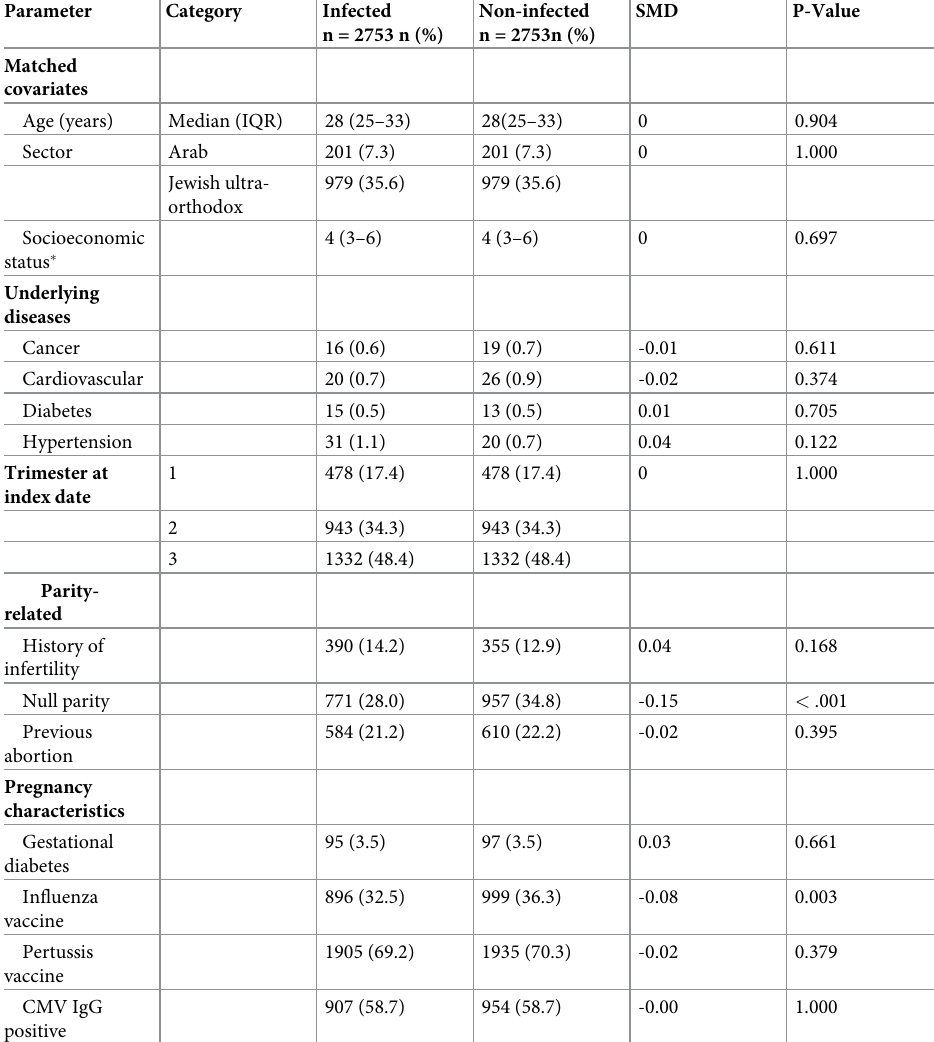
Table 1. Baseline characteristics of study population.